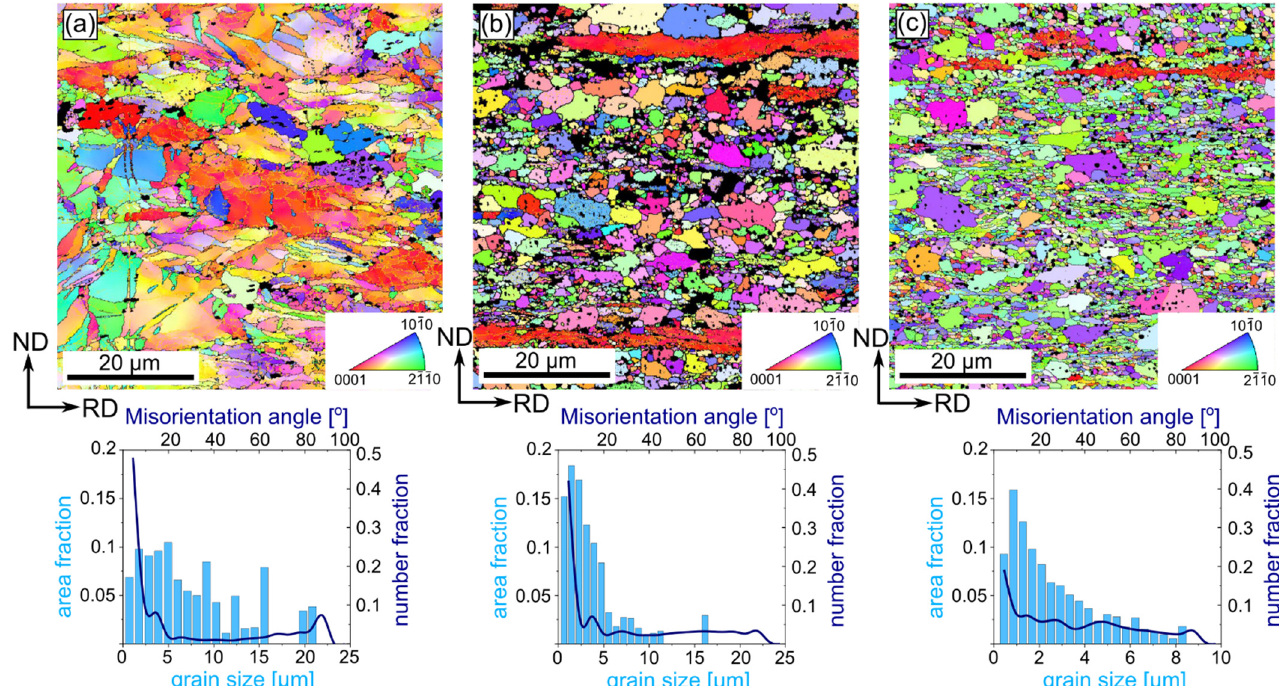
Figure 3. Orientation maps with the corresponding distribution of grain size and misorientation angle of the cold-rolled Zn-1Cu alloy with reduction rate 50% ( a ), 75% ( b ) and 90% ( c ). Dark areas correspond to the second phase and were excluded from the analysis. HAGBs and LAGBs were marked with black and yellow colors, respectively. Orientation maps are color-coded based on the IPF triangle depicted in the right corner with respect to the RD.